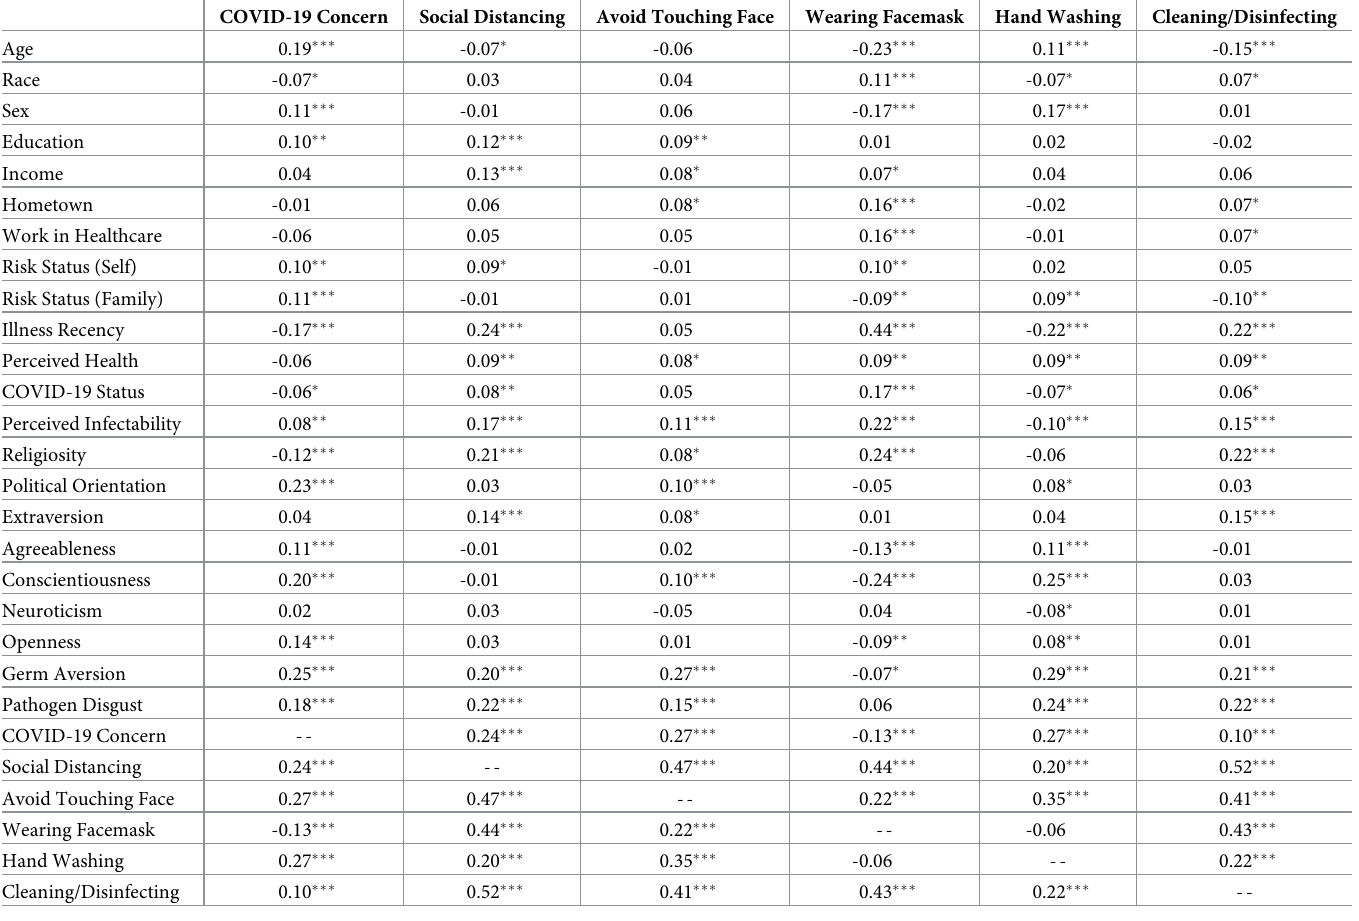
Table 2. Bivariate correlations between respondent characteristics and COVID-19 concern and preventative health behaviors. COVID-19 Concern Social Distancing Avoid Touching Face Wearing Facemask Hand Washing